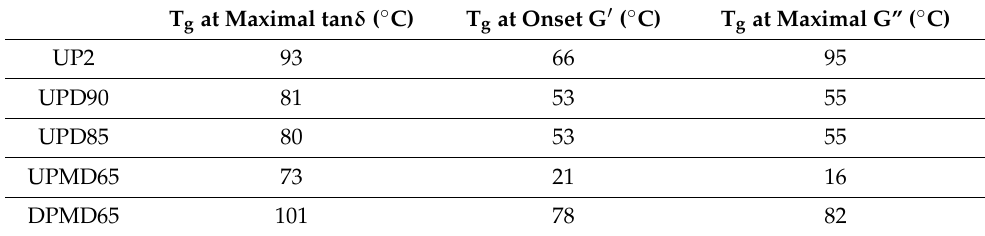
Table 11. Glass transition temperatures of